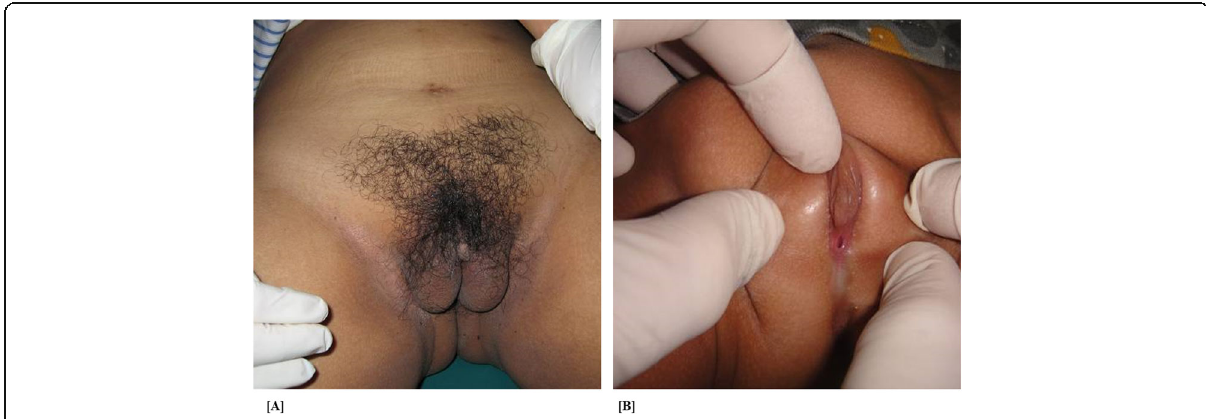
Fig. 3 The clinical presentation of AIS within family 1. a Noted bifid scrotal, micropenis, severe hypospadias, bilateral palpable testes in scrotal region in patient 7 (III:14). b Noted minimal scrotalization, severe hypospadias and bilateral palpable testes in scrotal region in patient 68